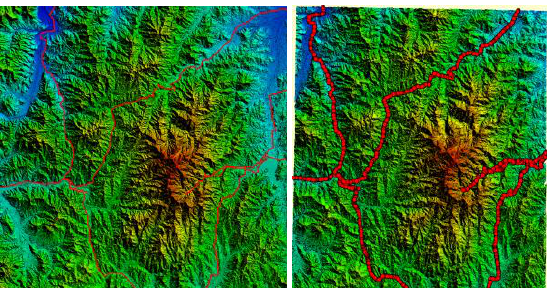
Figure 5. The road centre lines on reference DEM (left) and distribution of check points on DEM generated from WV-3 stereo-images